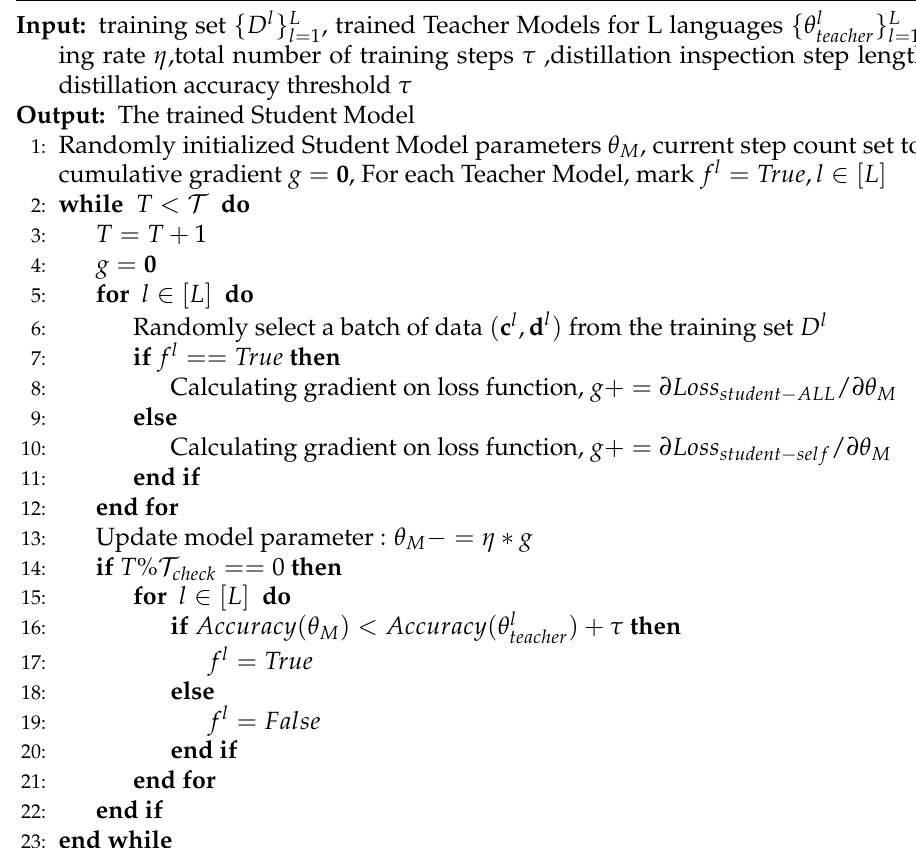
Algorithm 1 Knowledge distillation in multiple code languages